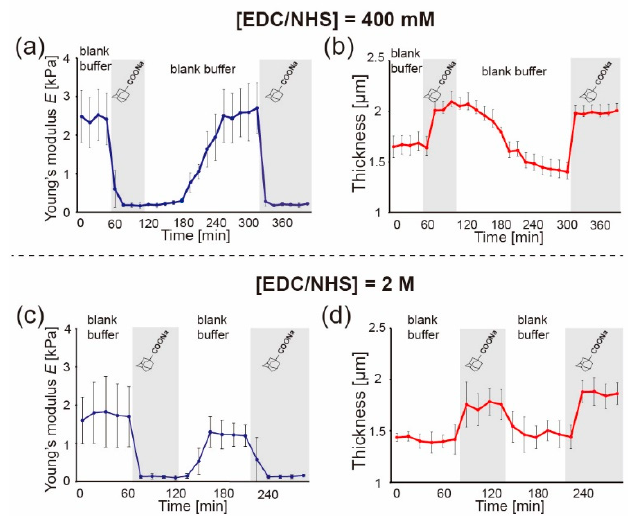
Figure 7. Young’s modulus ( a , c ) and thickness ( b , d ) of β CD-Gelatin/Ad-Gelatin fibers in the absence and presence of 5 mM Ad-COONa monitored by in situ AFM nano-indentation ( N = 3). Fibers were crosslinked in ( a , b ) 400 mM and ( c , d ) [ EDC ] = [ NHS ] = 2 M for 4 h.